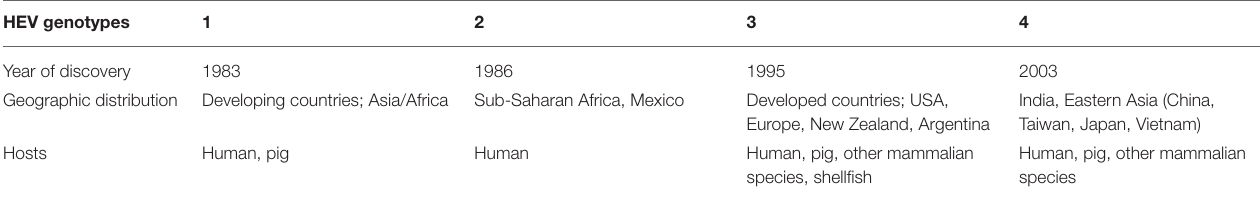
TABLE 1 | Characteristics of HEV